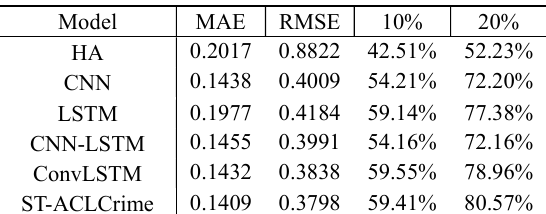
Table 3 . Comparisons the results of different models at 1000 meters spatial resolution.